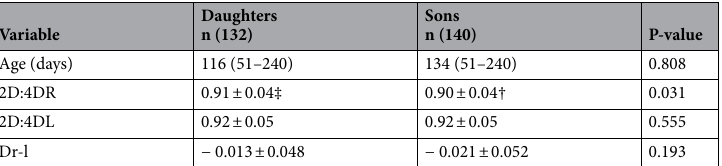
Table 1. Sociodemographic and anthropometric variables of the daughters and the sons involved in the study. Results presented as mean ± S D for parametric or median (IQR) for non-parametric variables. The mean or median values of sons were compared with those of daughters using the student t -test (unpaired, 2-tailed) for parametric and the Mann-witney U test (unpaired, 2-tailed) for non-parametric variables. Also, an intra- sex comparison of the right and the left digit ratio was performed using a student t -test (paired, 2-tailed). ‡ Significant at P = 0.002 when compared to 2D:4DL. † Significant at P < 0.001 when compared to 2D:4DL.